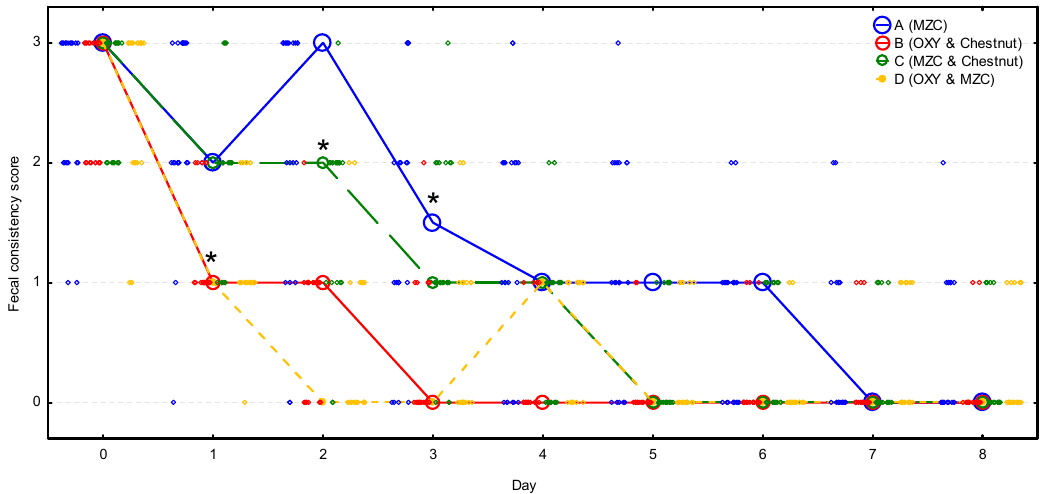
Figure 3. The change of the fecal consistency score (median denoted by circles and individual scores by diamonds) during the observation period in four groups ( n = 20 calves per group). Asterisks signify the moment when the score decreased significantly compared to the initial value in the group. MZC—micronized zeolite clinoptilolite, OXY—oxytetracycline.